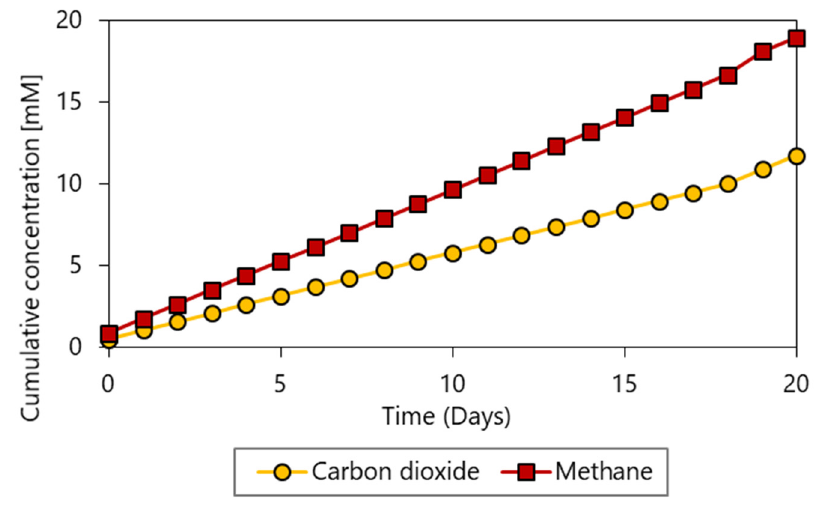
Figure 5. Cumulative concentrations of carbon dioxide and methane with time for the bioreactor run.